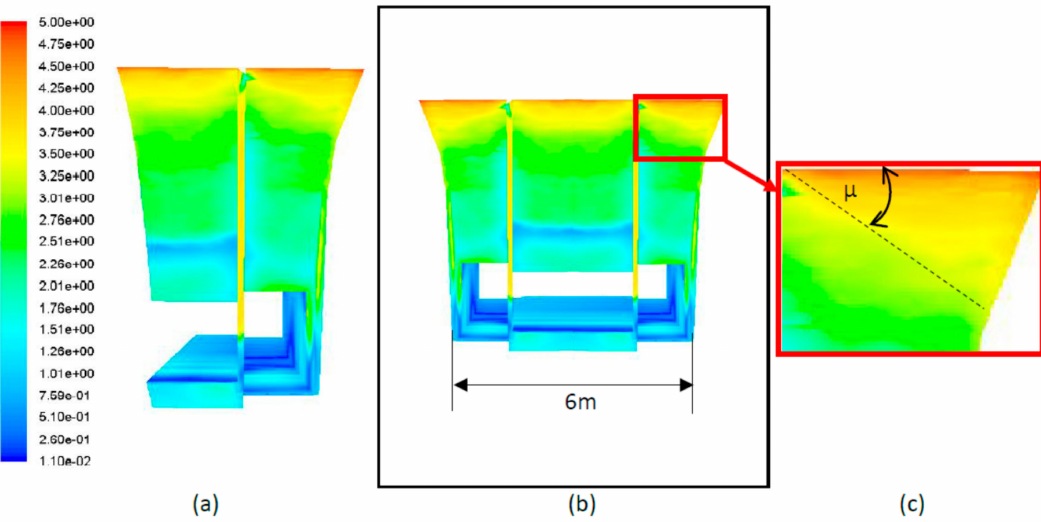
Figure 25. Ramjet and scramjet ( a , b ) full front view with ( c ) shock angle